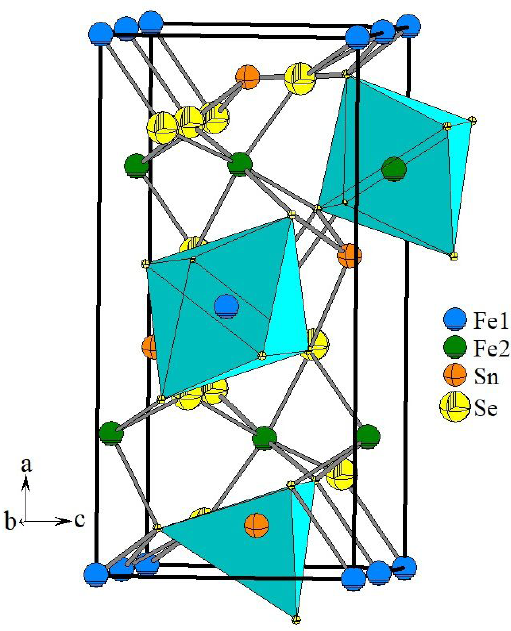
Figure 3. Unit cell diagram in the ac plane of the olivine type compound Fe SnSe ( Pnma ) showing the FeSe 2 4 SnSe 4